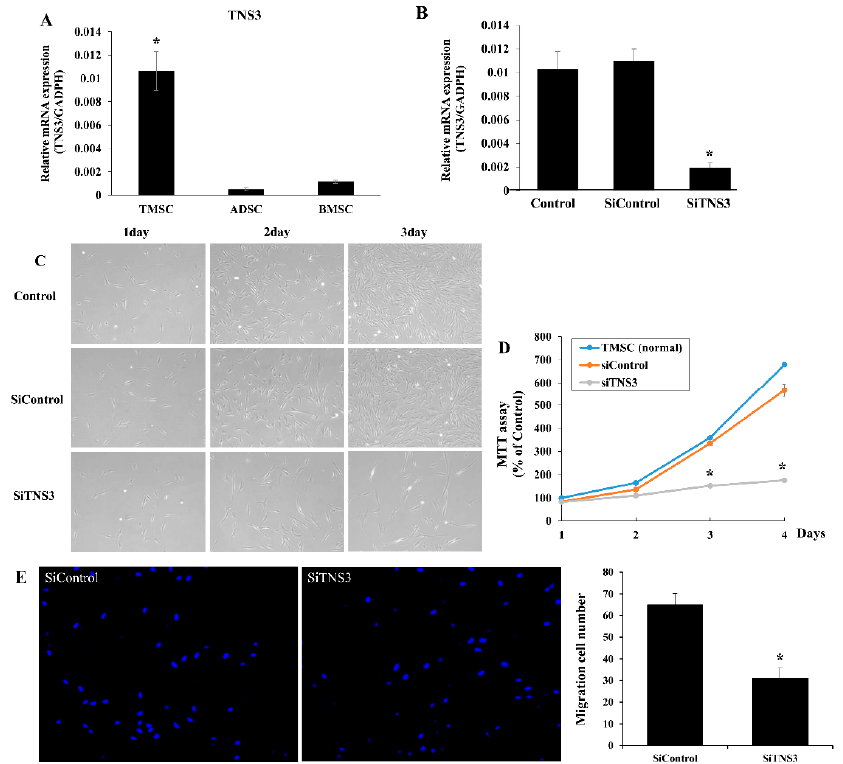
Figure 1. Tensin-3 (TNS3) regulates the proliferation of tonsil mesenchymal stem cells (TMSC). ( A ) TNS3 showed increased expression levels in TMSCs compared to in adipose tissue-derived MSCs (ADSCs) and bone marrow-derived MSCs (BMSC). ( B ) siRNA TNS3 (siTNS3) transfection of TMSCs significantly reduced TNS3 expression in RT-PCR. ( C ) Photomicrographs after siTNS3 transfection showed reduced cell numbers, but no morphologic changes were observed in transfected cells compared to controls. ( D ) 3-(4,5-dimethylthiazol-2-yl)-2,5-diphenyltetrazolium bromide (MTT) assay results. Silencing of TNS3 led to a decrease in cell growth rates. The difference compared to the control was significant on days 3 and 4. ( E ) Migration cell numbers were also significantly reduced after transfection with siTNS3. *, p < 0.05 compared to the control. n = 4. Columns and error bars represent the mean ± standard deviation.